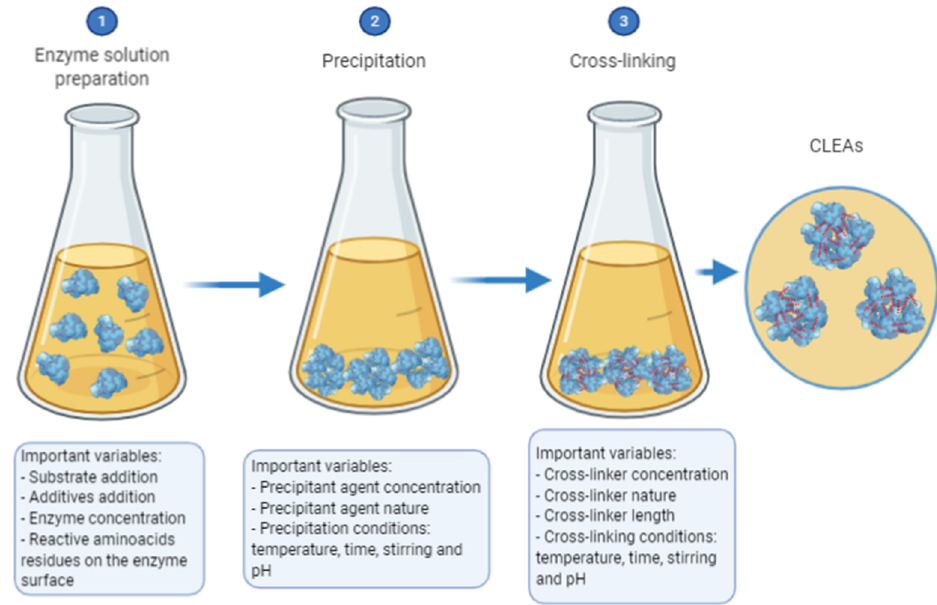
Figure 1. Simplified protocol for CLEAs production. The cross-linkers are represented by the lines in red. Adapted from reference [125].